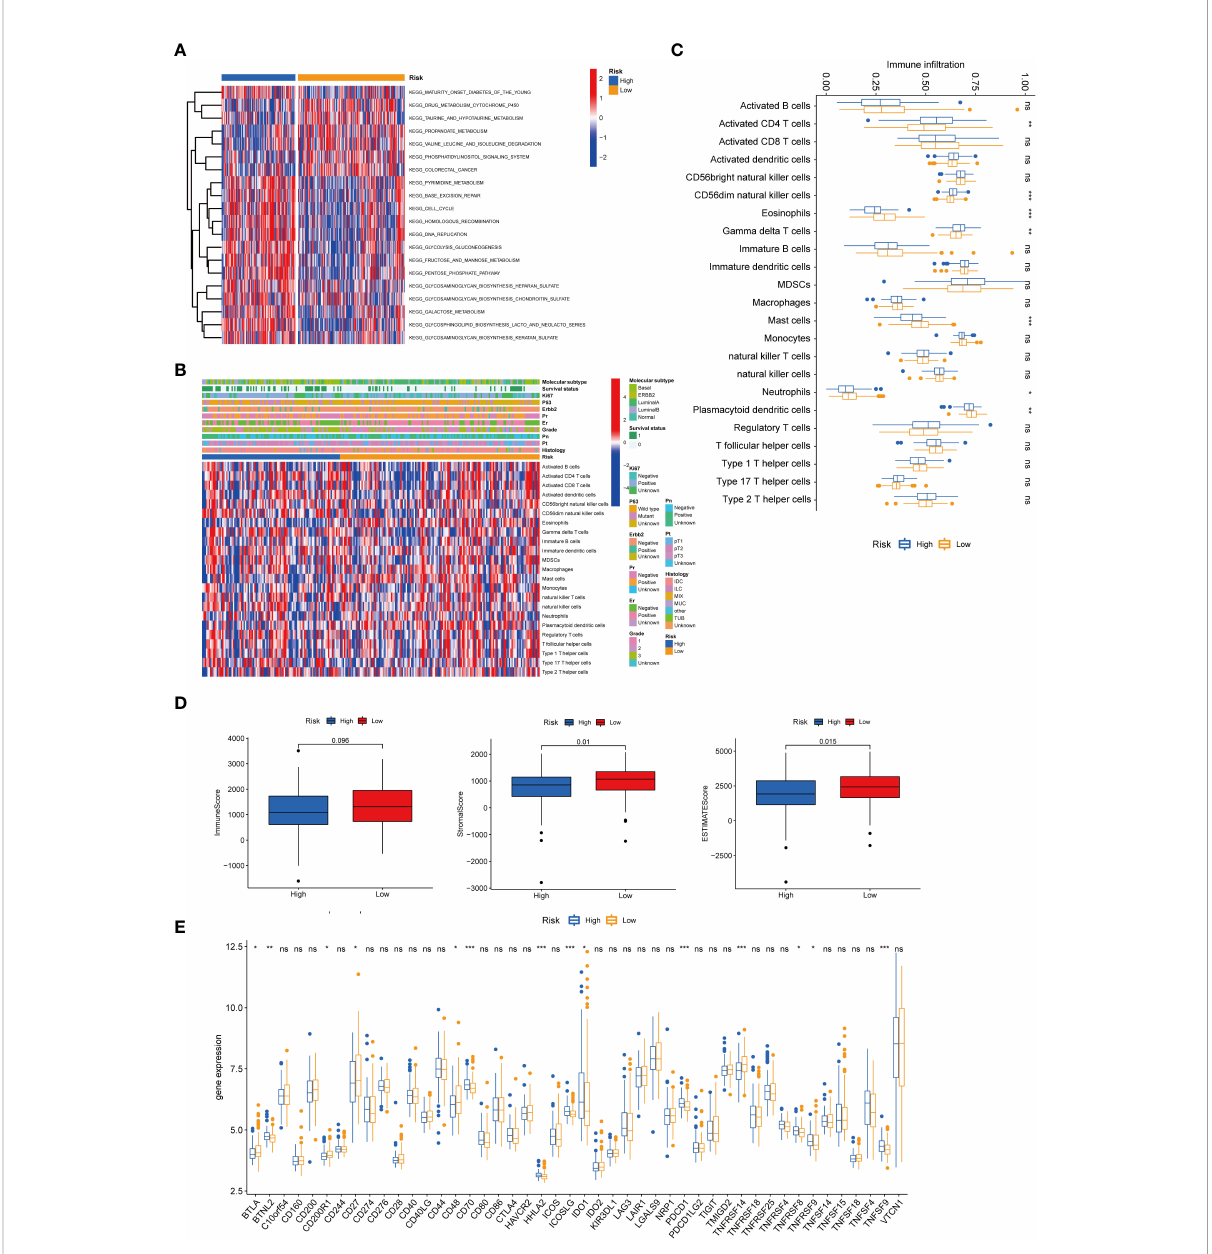
FIGURE 7 Correlations of the tumor immune cell microenvironment and risk score. (A) GSVA of the biological pathways between the two risk groups, in which red and blue represent activated and inhibited pathways, respectively. (B) Heatmap of the tumor-in fi ltrating cell in the two risk groups. (C) The abundance of the 23 in fi ltrating immune cell types in the two risk groups. (D) Correlations between the two subtypes and TME score. (E) Differences in the expression of checkpoints in the two risk groups. BRCA, breast cancer; GSVA, gene set variation analysis; TME, tumor microenvironment. * P value < 0.05; ** P value < 0.01; *** P value <